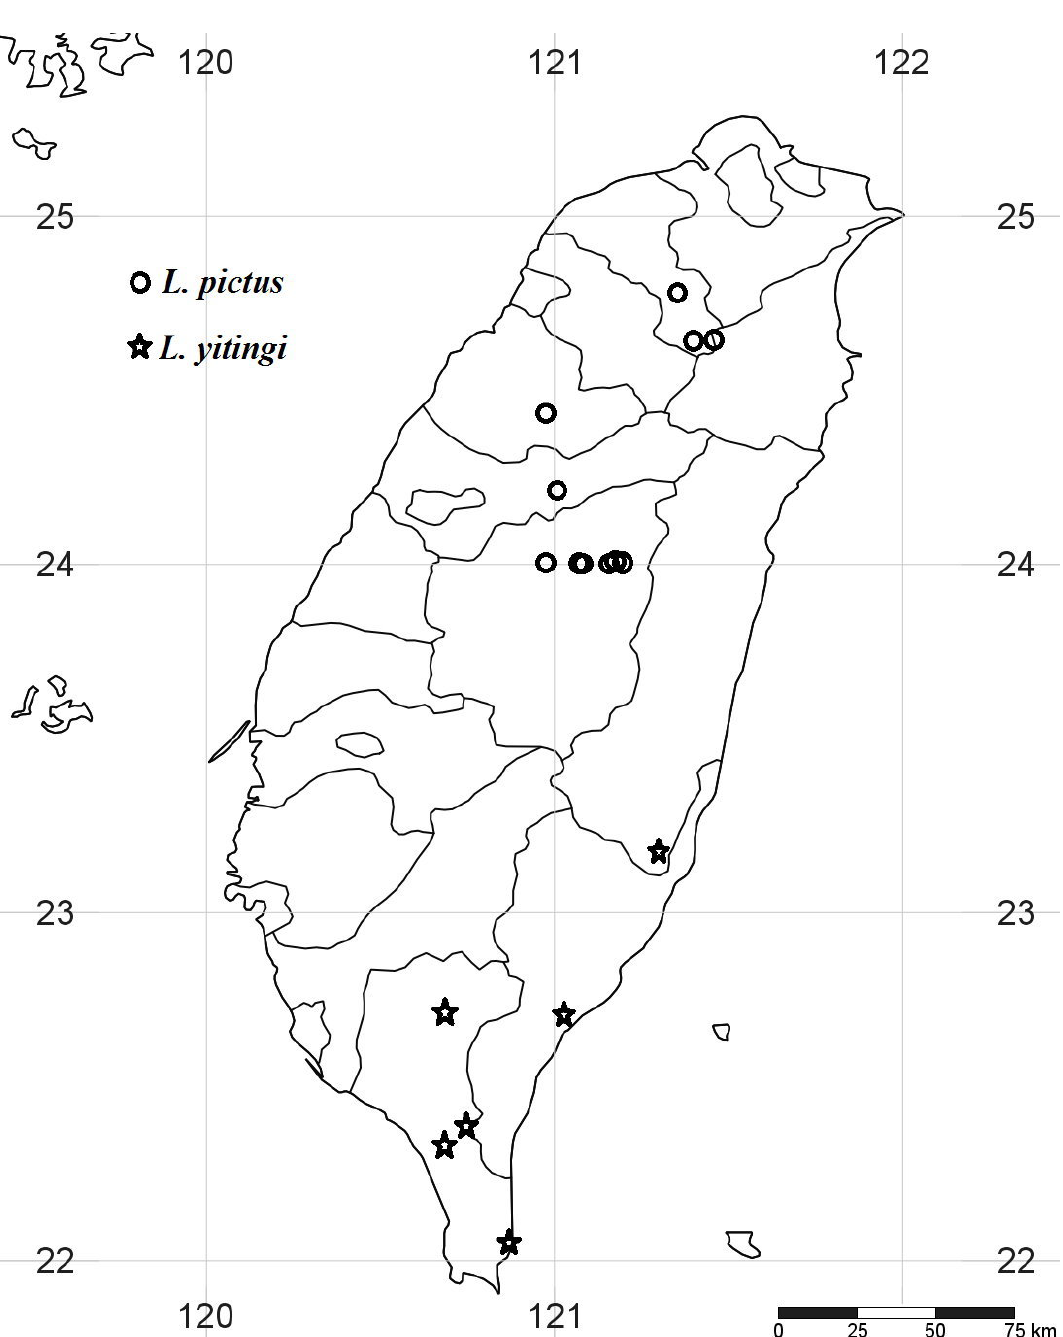
Fig. 7. Distribution map of Lycocerus pictus (Wittmer, 1983) and L. yitingi Hsiao & Okushima sp. nov. from